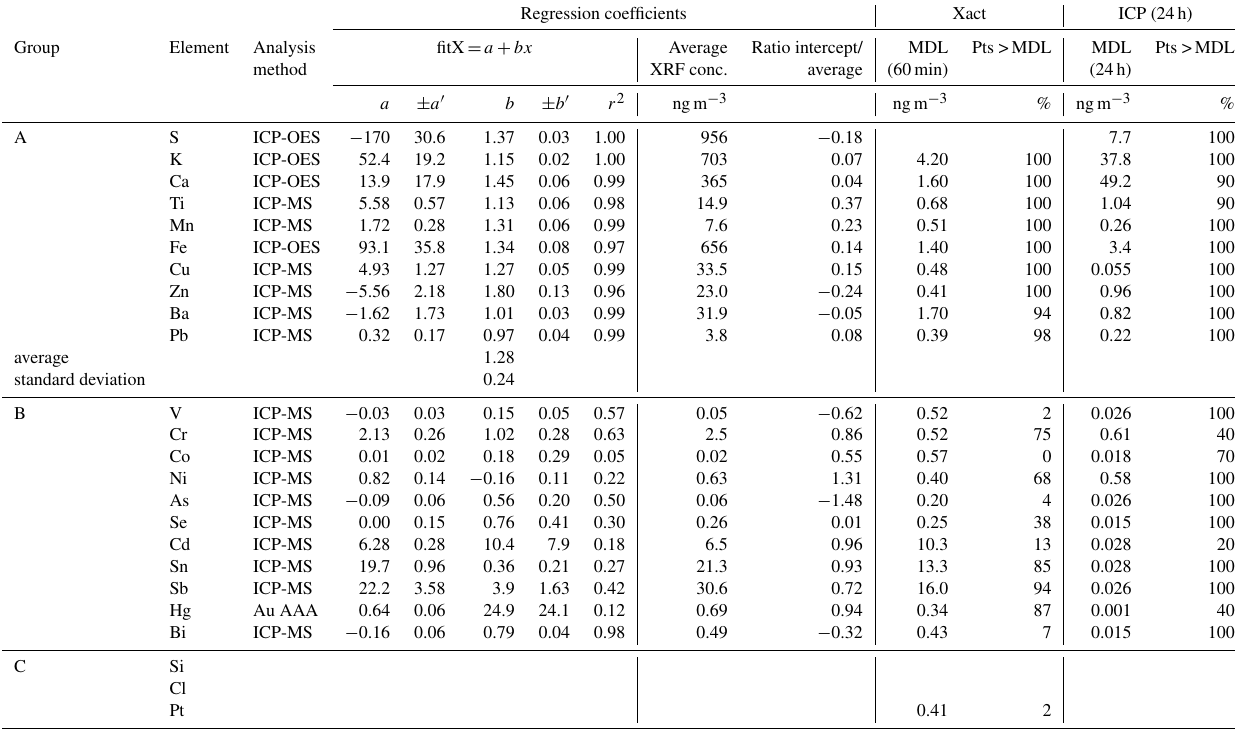
Table 1. Regression coefficients for the comparison of Xact 625 and offline data. The 1h values of the Xact 625 were averaged to 24h values. Primed quantities are